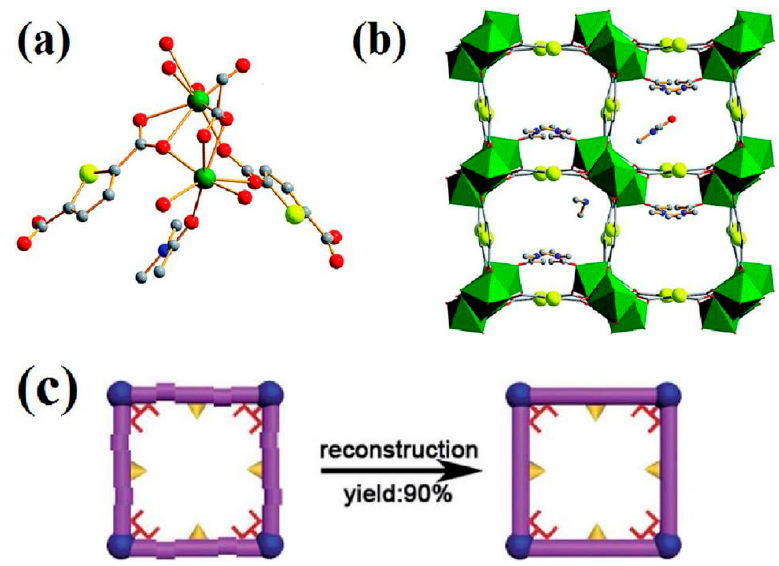
Figure 7. ( a ) The coordination environment of FJI-H9; C, grey; N, blue; O, red; S, yellow; Ca, green; H was omitted for clarity; ( b ) The 3D framework of FJI-H9. Sulfur atoms are highlighted as yellow balls, and Ca atoms are highlighted as green polyhedral; ( c ) In situ regeneration of the used framework. Reproduced with permission from [87]. Copyright Royal Society of Chemistry, 2016.